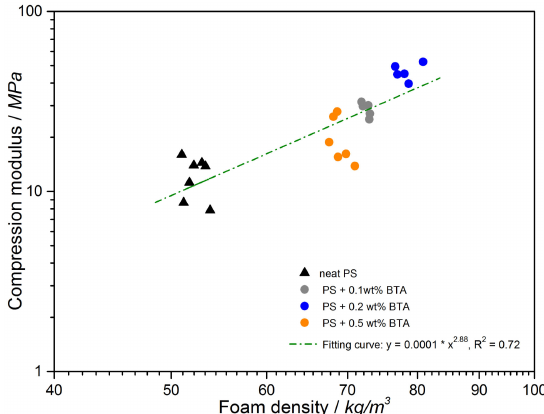
Figure 4. Change in the compression modulus independent of foam